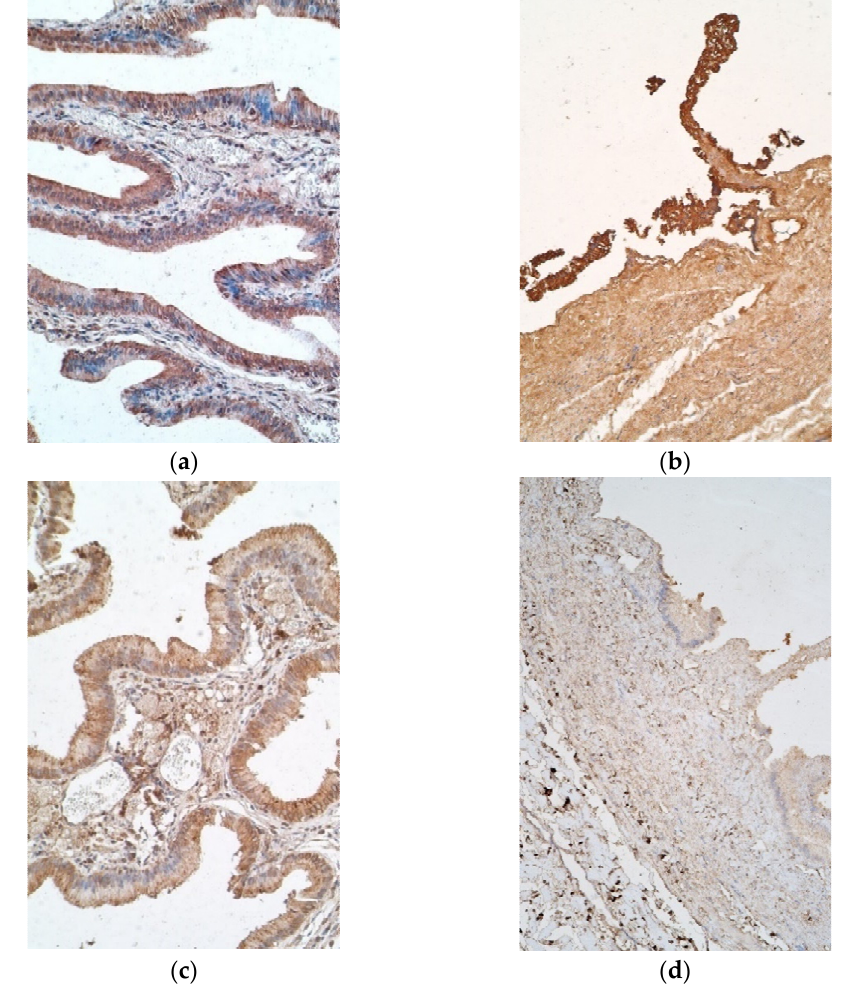
Figure 3. Micrographs of gallbladder in children with cholecystitis and in controls. ( a ) Note numerous IL-7 positive epitheliocytes and moderate number of IL-7 positive cells in connective tissue. IL-7 IMH, × 200; ( b ) note numerous IL-7 positive cells only in the epithelium of control tissue. IL-7 IMH, × 200; ( c ) few to moderate number of IL-8 positive epithelial and connective tissue cells of the patient. IL-8 IMH, × 200; ( d ) control tissue containing only few IL-8 positive cells. IL-8 IMH, × 200. Il-10 marked few to moderate positive cells in the epithelium of patients, while con- IL-8 positive epitheliocytes varied highly in patient samples, more frequently having trols demonstrated few samples with numerous positive cells. The appearance of IL-10 none to few positive cells, while controls mostly showed moderate to numerous positive cells in connective tissue was similar in patient and control samples, both con- taining none to few positive cells (Figure 4a,b).